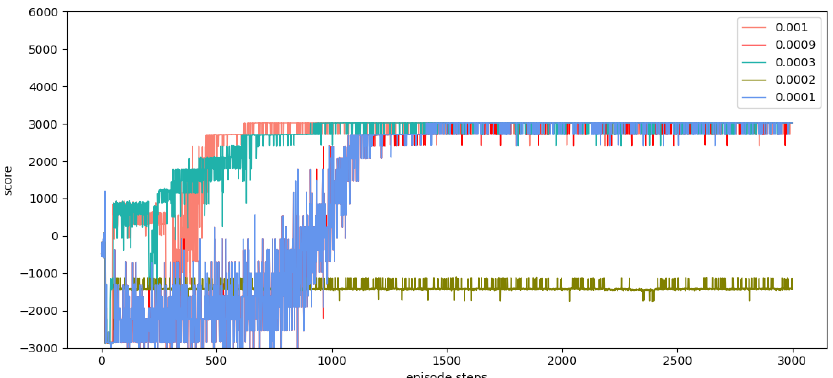
Figure 8. Training results of SD-TD3 (6) algorithm model in Environment 2.